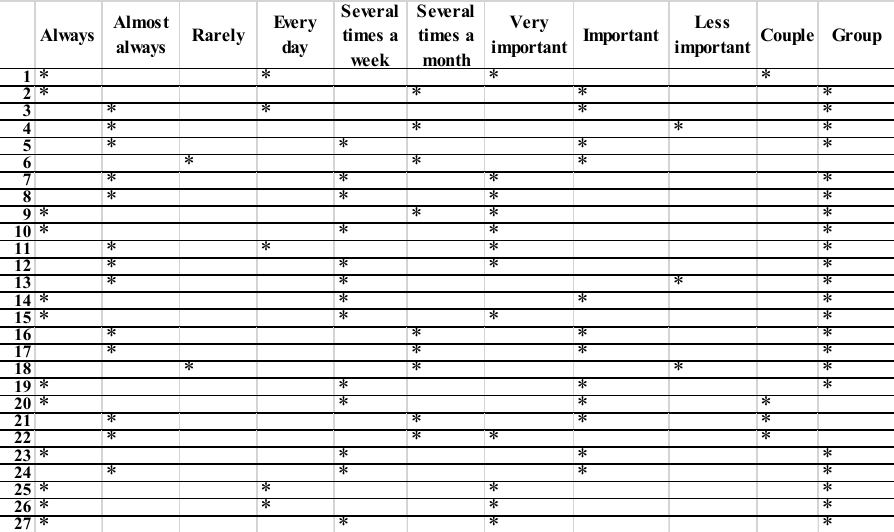
Picture 2: Classifying students into